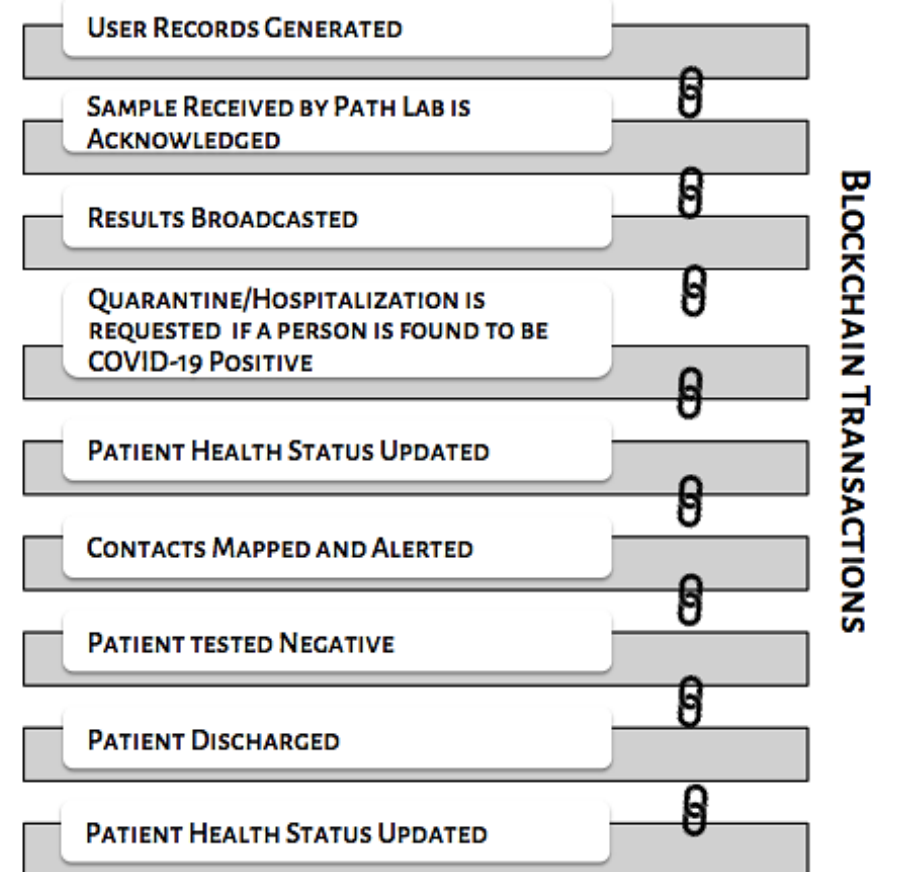
Figure 5. Data transaction flow in a blockchain-based contact tracing